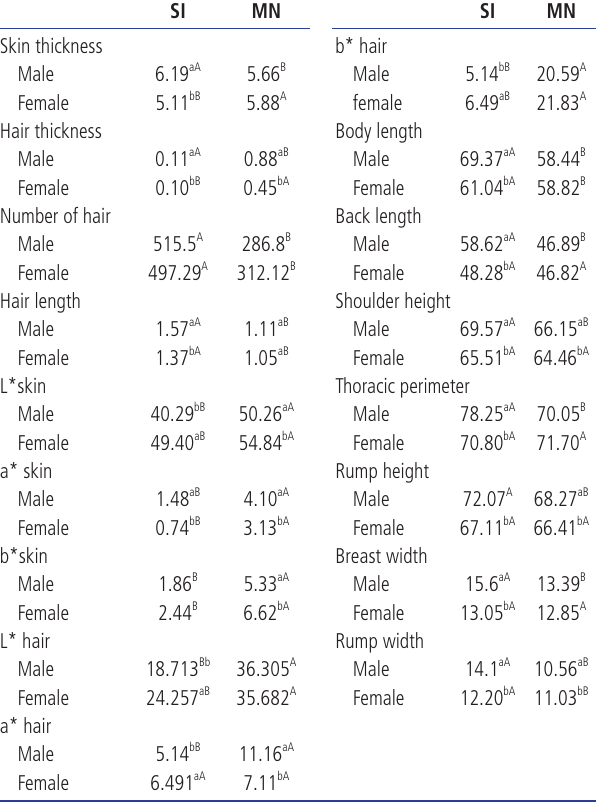
Table 6. Correlations between physical characteristics, physiological parameters and heat tolerance indices 1) RT